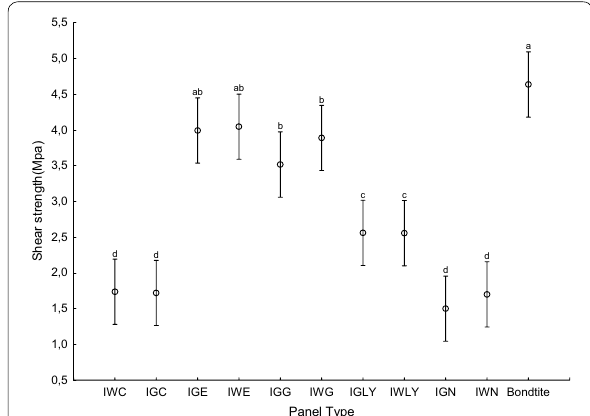
Fig. 8 Shear strengths of Irvingia‑based wood adhesives (Error bars with same or similar letters are not significantly different, p <